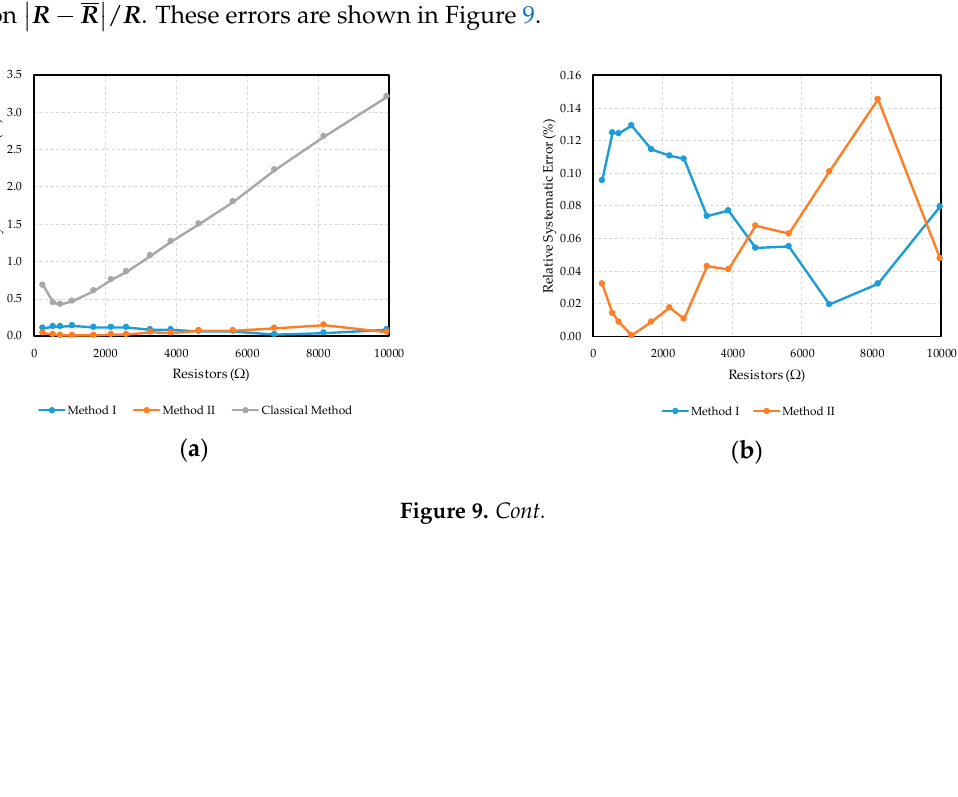
Table 2. Accuracy data for Rij estimation with a value of 270 Ω for the row and column of the resistor under test.